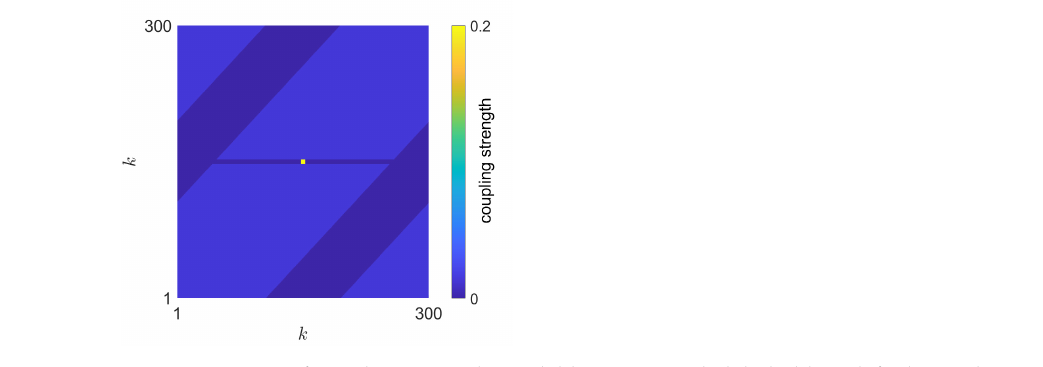
Figure 1. Matrix of coupling strength. Dark blue: not coupled; light blue: default coupling strength; yellow: highly